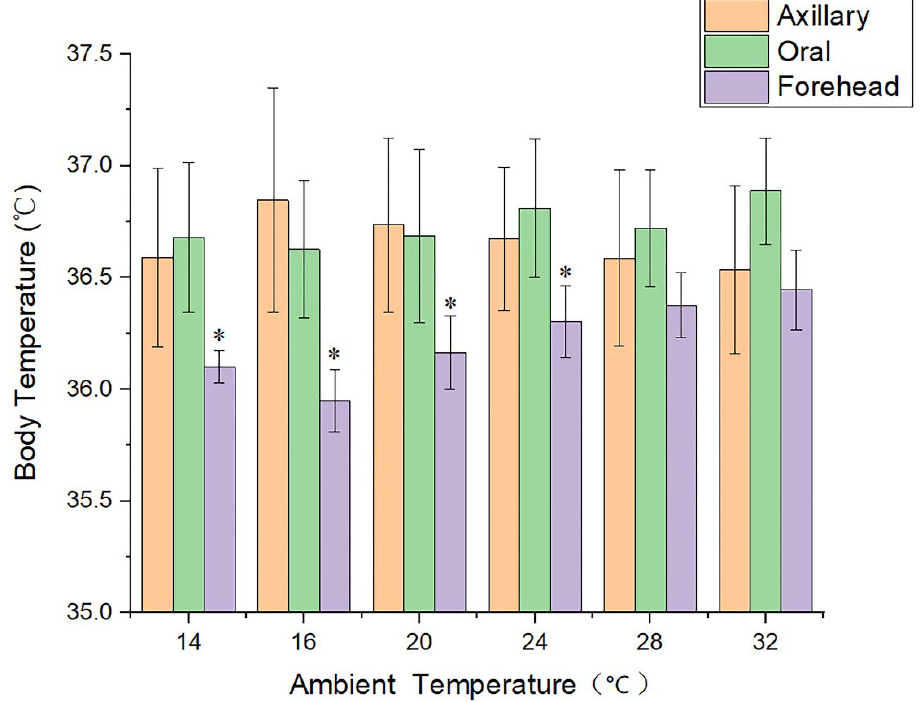
Figure 1. Histogram of the axillary temperature, oral temperature, and forehead temperature data under different ambient temperature conditions. * means significant statistical difference.